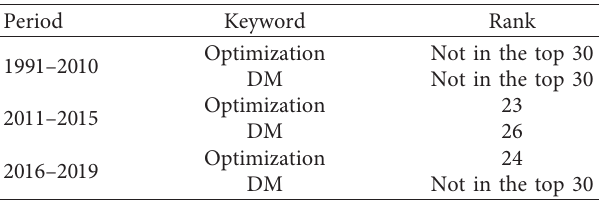
Figure 11: Bar chart of the top 30 authors’ keywords during 2016–2019. Table 3: Rank of optimization and DM keywords in the top 30 keywords in 3 periods.